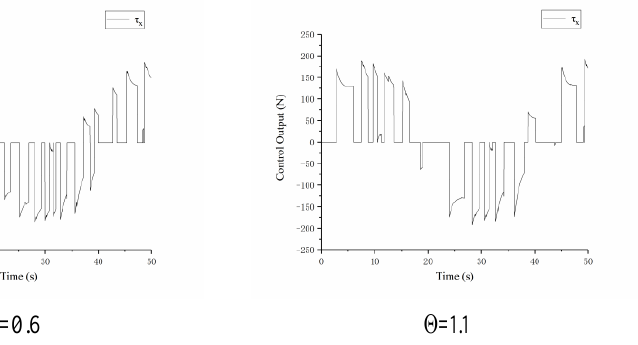
Figure 10. Control output of control law optimization scheme.